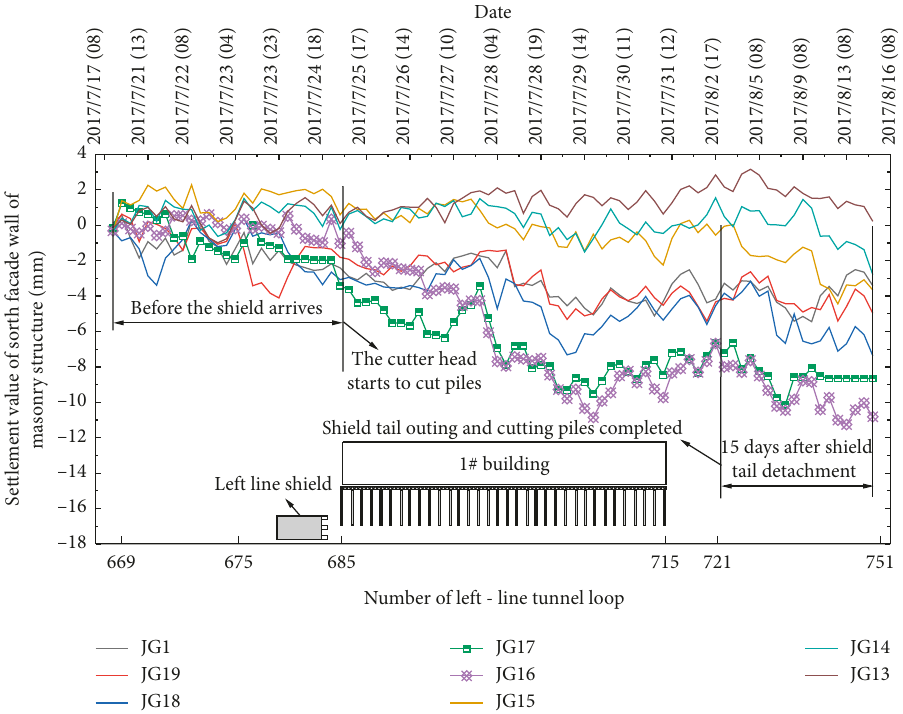
Figure 12: Settlement time-history curve of south facade wall of the building.